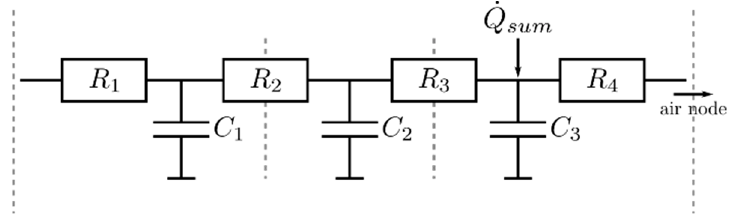
Figure A1. RC model for a multi-layer internal surface.